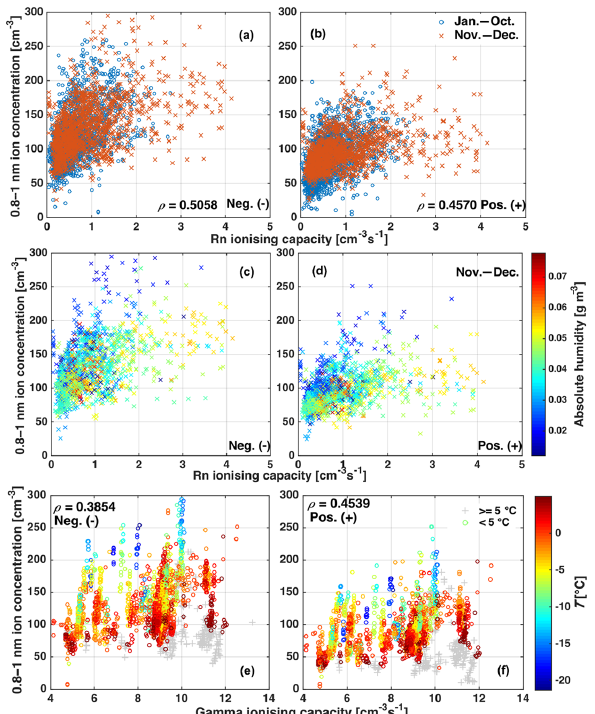
Figure 10. Relationship between the hourly ionising capacity and the 0.8–1nm ion concentration when the condensation sink (CS) is below 0.001s − 1 . Upper panels (a, b) : radon ionising capacities vs. 0.8–1nm ion concentrations for January–October (circle) and for November–December (cross). Middle panels (c, d) : radon ionising capacities vs. 0.8–1nm ion concentrations with absolute humidity on the colour scale for November–December. Lower panel: gamma ionising capacities vs. 0.8–1nm ion concentrations with air tem- perature ( T ) on the colour scale. The Spearman’s rank correlation coefficients ( ρ ) in the upper panel were determined using all avail- able data and those in the lower panel were determined between the gamma ionising capacity and the 0.8–1nm ion concentration, when the T was below 5 ◦